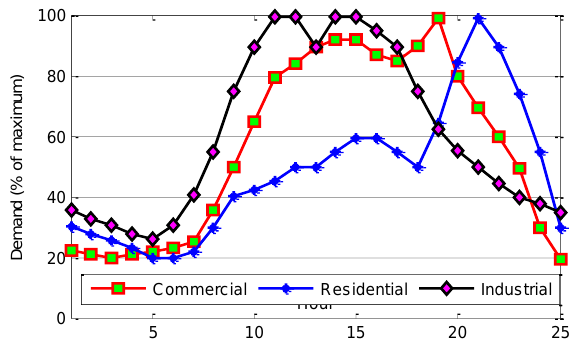
Figure 8. The 24 h temperature profile of the studied system.